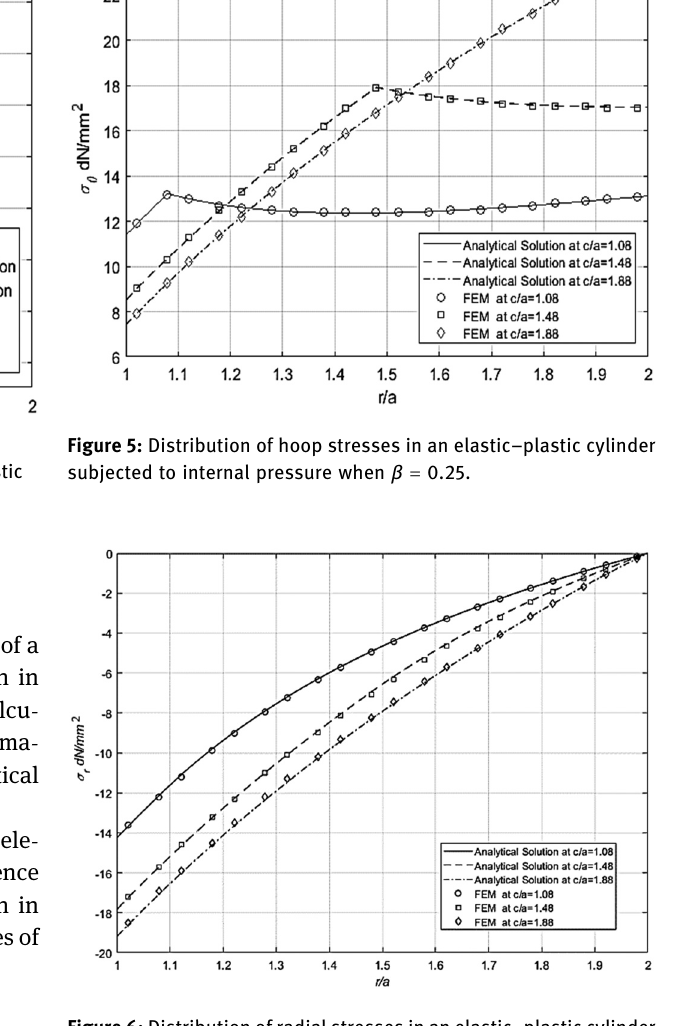
Figure 6: Distribution of radial stresses in an elastic – plastic cylinder subjected to internal pressure when β 0.25 = .